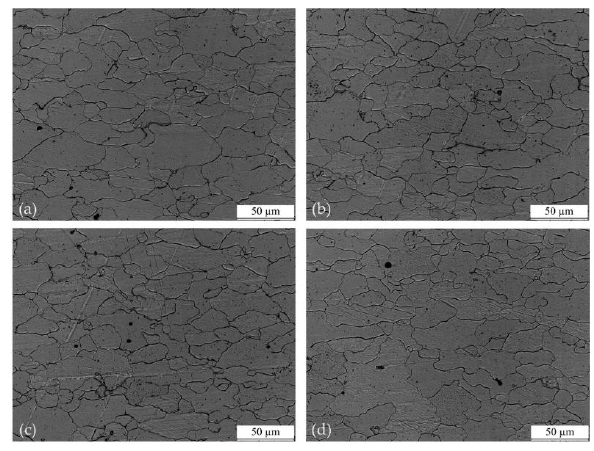
Figure 5. Cross-section microstructure applied different vibration frequencies: ( a ) Without vibration; ( b ) Applied vibration with frequency 10 Hz; ( c ) Applied vibration with frequency 20 Hz; ( d ) Applied vibration with frequency 30 Hz.